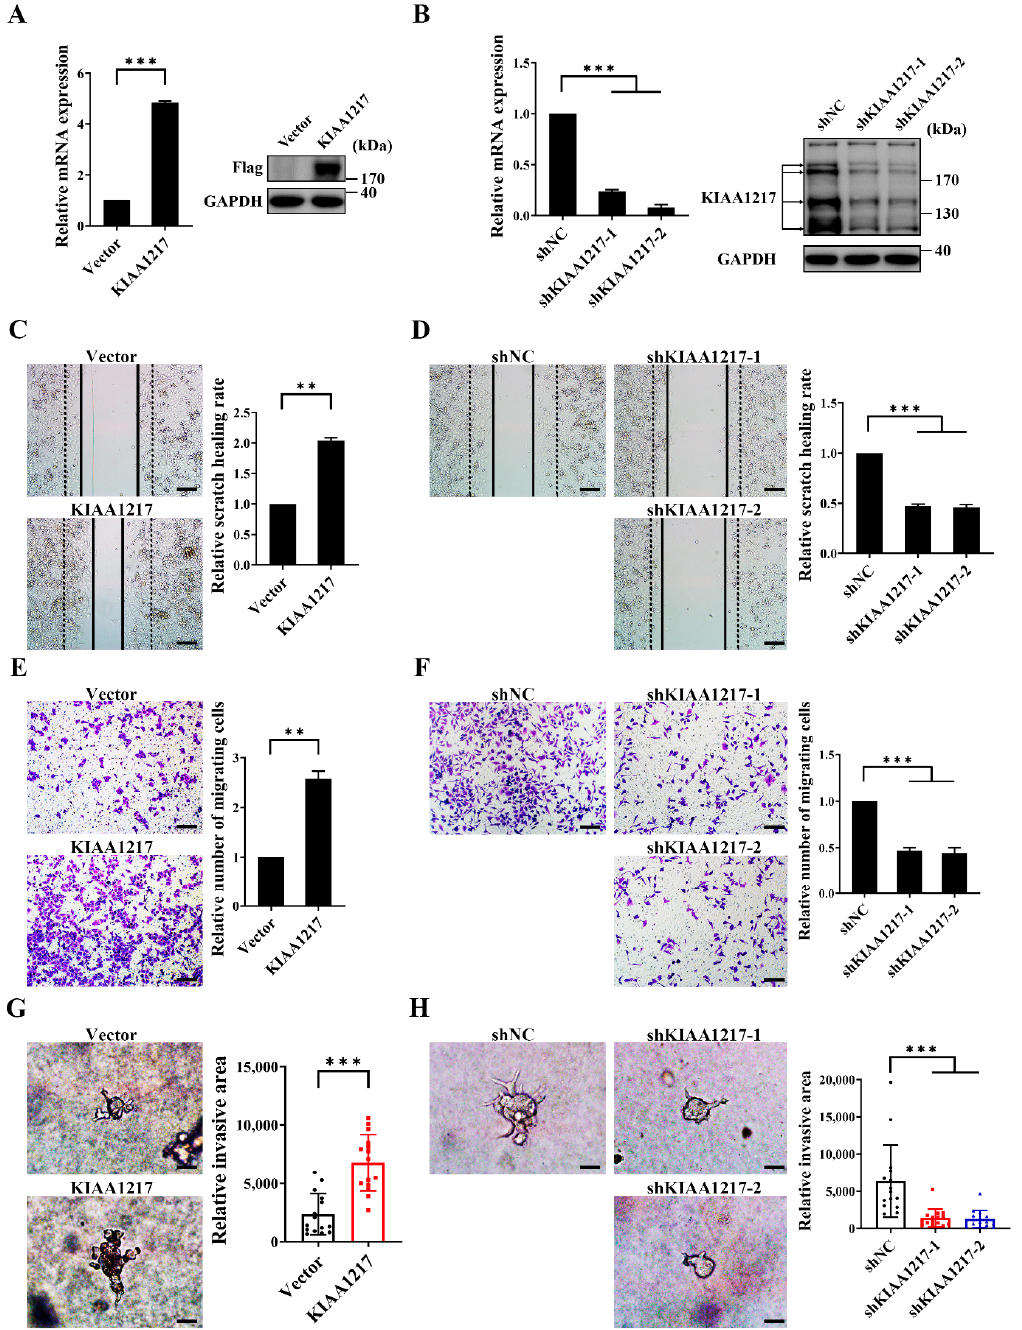
Figure 2. KIAA1217 promoted cell migration and invasion in vitro. ( A , B ) The overexpression ( A ) or silencing ( B ) of KIAA1217 in HepG2 cells were confirmed using RT–qPCR and Western blot analyses. β -Actin and GAPDH were used as internal controls for RT–qPCR and Western blot, respectively. ( C , D ) Wound-healing assays were performed to detect the migration of HepG2 cells with KIAA1217 overexpression ( C ) or knockdown ( D ) at 48 h after scratching. Magnification × 100; scale bars: 100 µ m. ( E , F ) Transwell migration assays were performed to detect the migration of HepG2 cells with KIAA1217 overexpression ( E ) or silencing ( F ). Magnification × 100; scale bars: 100 µ m. ( G , H ) Cancer cell spheroid invasion assays in a 3D setting were performed to detect the invasion of HepG2 cells with KIAA1217 overexpression ( G ) or knockdown ( H ). Magnification × 200; scale bars: 5 µ m. ** p < 0.01; *** p < 0.001. Error bars: